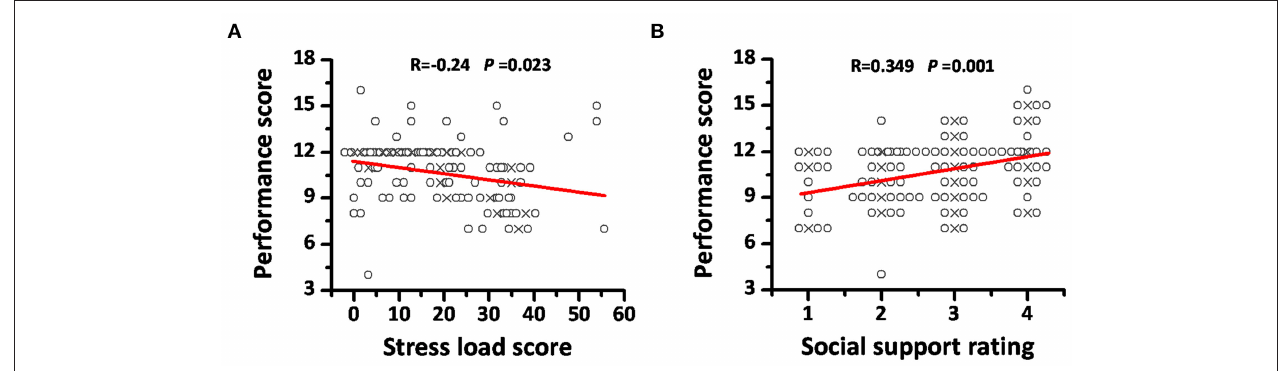
FIGURE 2 | The correlations between the stress load score, social support rating, and the performance score. (A) The inverse correlation between the stress load score and the performance score. Stress load scores were calculated as normalized ( × 100 to make it from 0 to 100) ratios between the item score summation and the possible max score in the 21-item questionnaire. Performance scores were calculated as the summation of four performance items scores. (B) The positive correlation between social support rating and the performance scores. Social supporting rating was achieved by inquiring how many social and family support the rescuers could receive during the rescue process: < 50% (rating as 1), 50–80% (rating as 2), 80–100% (rating as 3), or more than 100% (rating as 4) compared to their support before rescue. “ × ” means the central position of overlapped points, and overlapped points were plotted as offset.